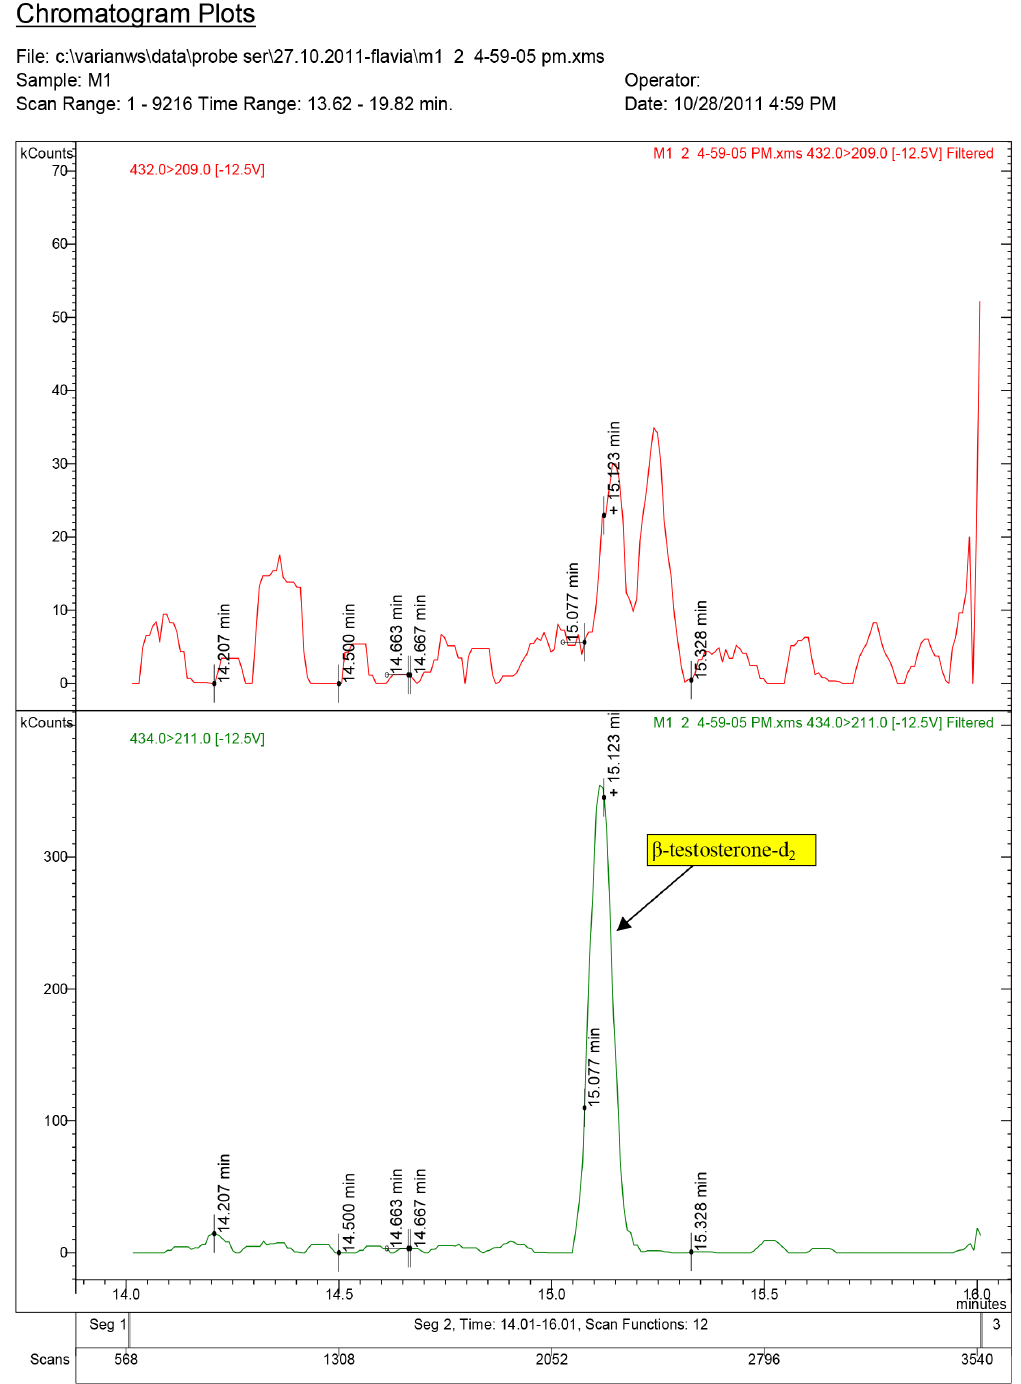
Figure 3. Diagnostic ions for testosterone in the Control group (injected with white sesame oil, 0.10 ml/rat).